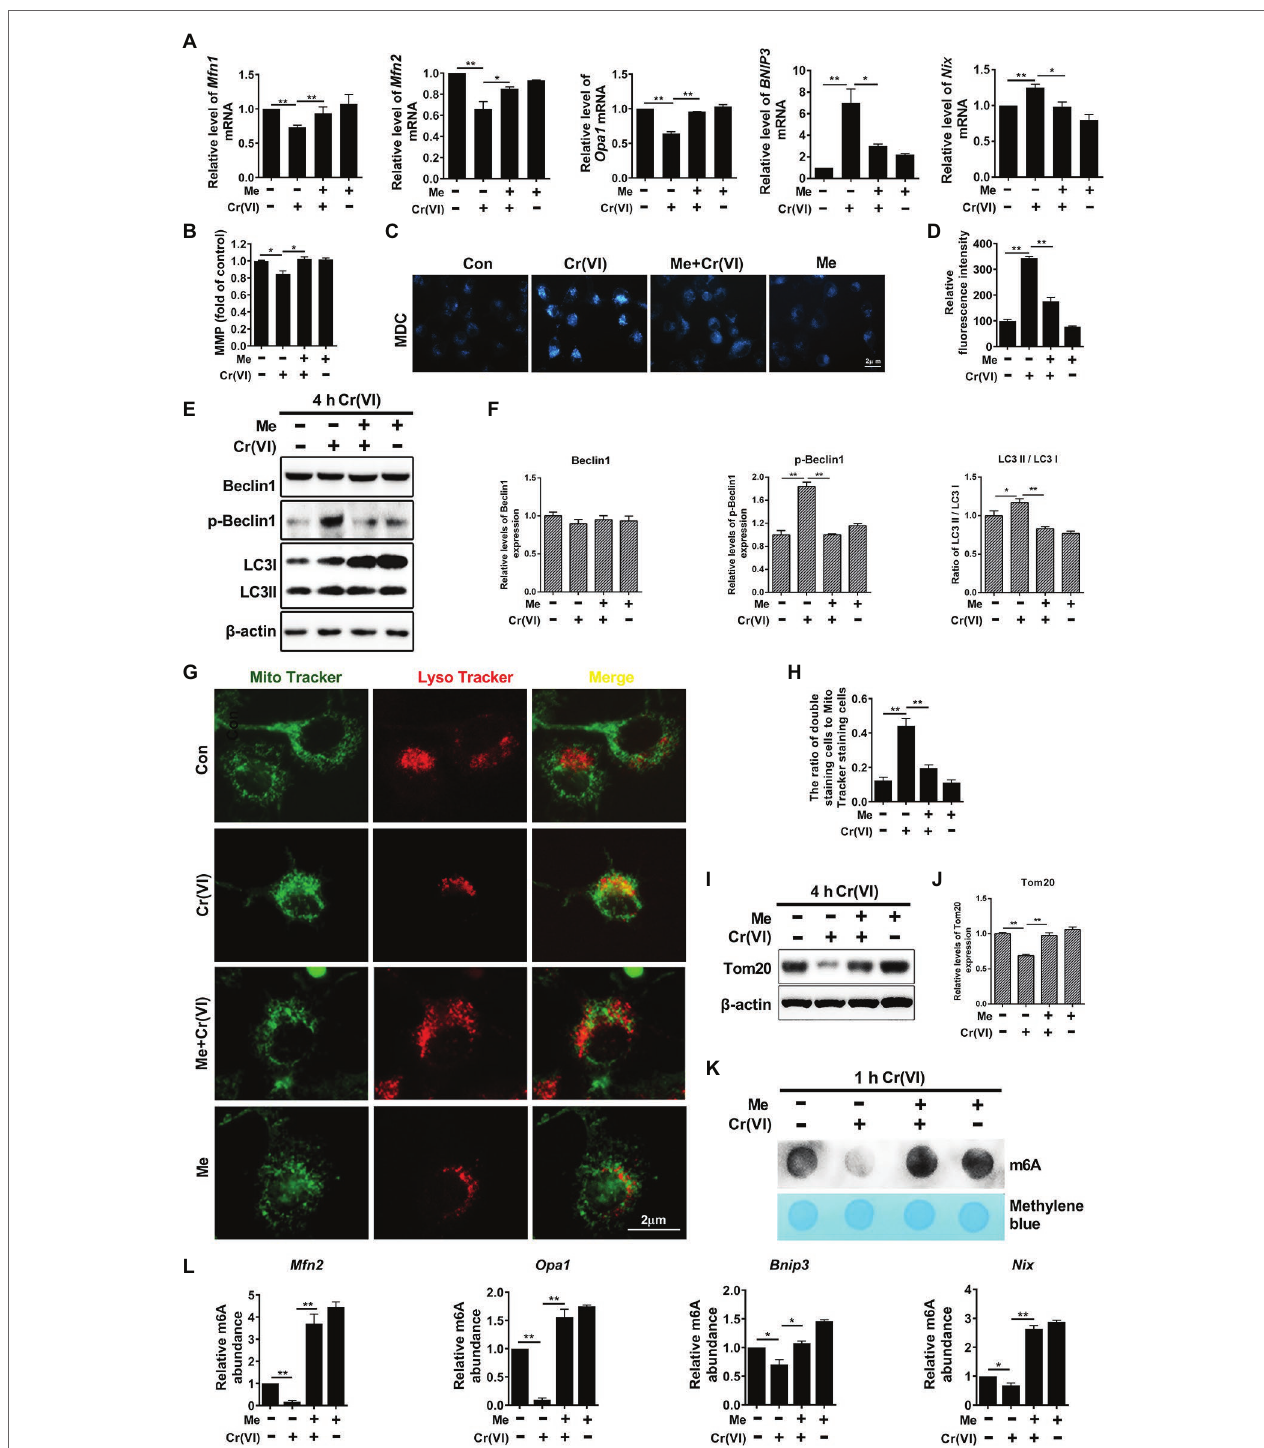
FIGURE 7 | Melatonin attenuated Cr (VI)-induced mitochondrial dynamic disorders and mitophagy via RNA m 6 A modification in SSCs/progenitors. (A) qPCR analysis of Mfn1 , Mfn2 , Opa1 , Bnip3 , and Nix in the control, Cr (VI), melatonin + Cr (VI), and melatonin-treated SSCs/progenitors. (B) MMP in the control, Cr (VI), melatonin + Cr (VI), and melatonin-treated SSCs/progenitors, as detected by the lipophilic cationic dye JC-1. (C) MDC staining for autophagic vacuoles in the control, Cr (VI), melatonin + Cr (VI), and melatonin-treated SSCs/progenitors. Bar = 2 μ m. (D) The relative fluorescence intensity of MDC in the control, Cr (VI), melatonin + Cr (VI), and melatonin-treated SSCs/progenitors. (E) Western blot analysis of the expression levels of autophagy markers Beclin1, p-Beclin1, and LC3